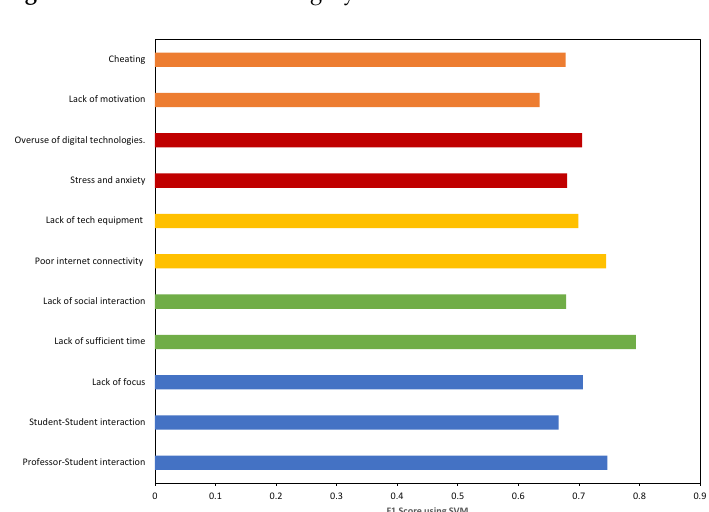
Figure 6. F1 score for each category.